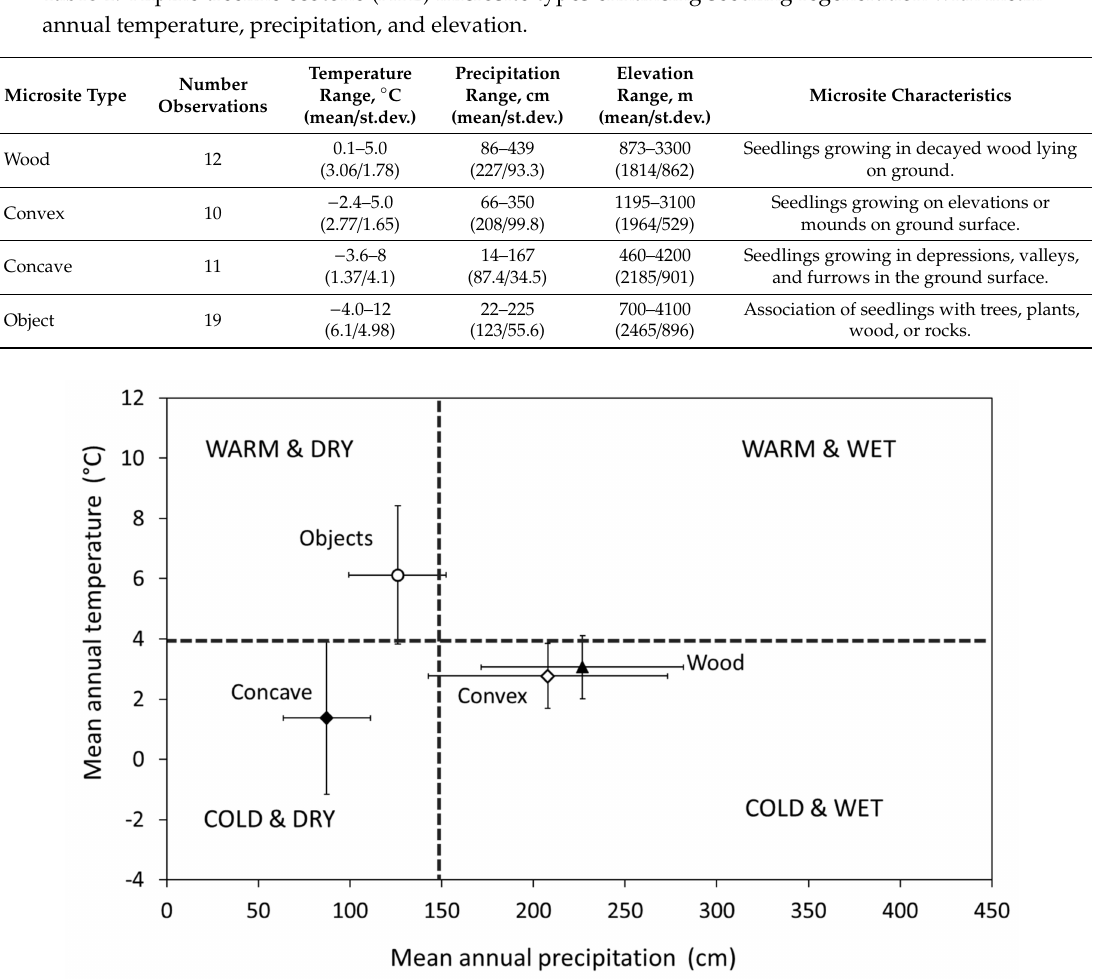
Figure 3. Alpine ecotone treeline microsite presence within four climate zones. Climate zones were di ff erentiated (as indicated by dashed lines) by significant annual temperature di ff erences between concavity and object microsites and significant annual precipitation di ff erences for wood / convexity microsites and concavity / object microsites. Dashed lines indicate visual splits of precipitation and temperature based on microsite population groupings. Error bars indicate 95% confidence